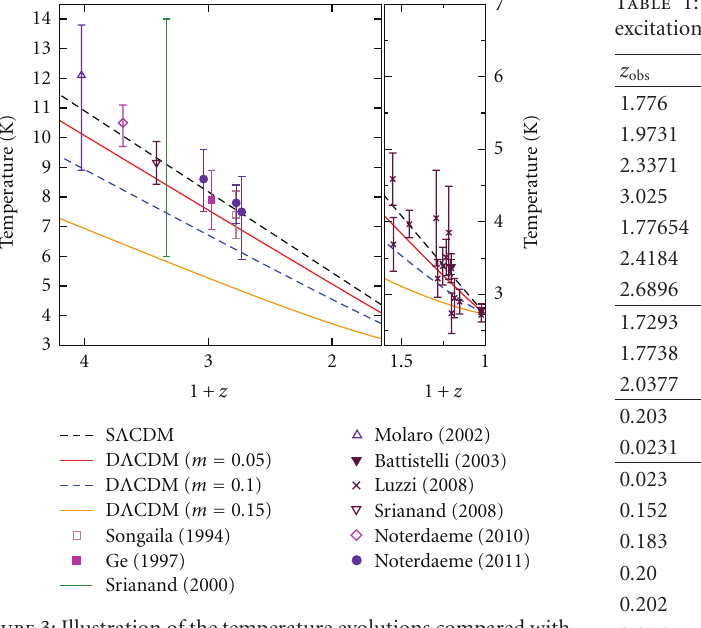
Figure 3: Illustration of the temperature evolutions compared with CMB observations. The left panel is the results at z > 0 . 6. The right is same, but at z < 0 . 6.